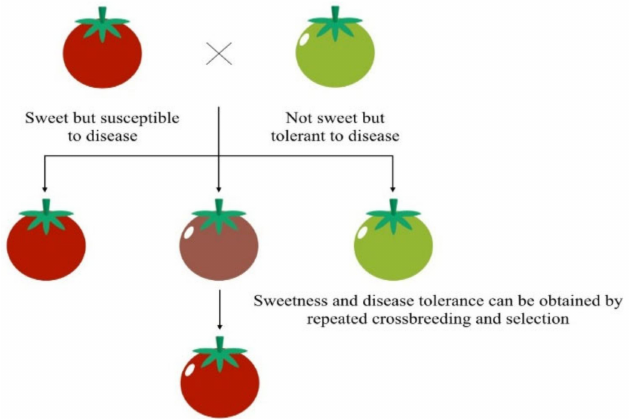
Figure 3. Selective tomato breeding. Icons made by Freepik and Smashicons from www.flaticon.com (accessed on 1 December 2021). Adapted from